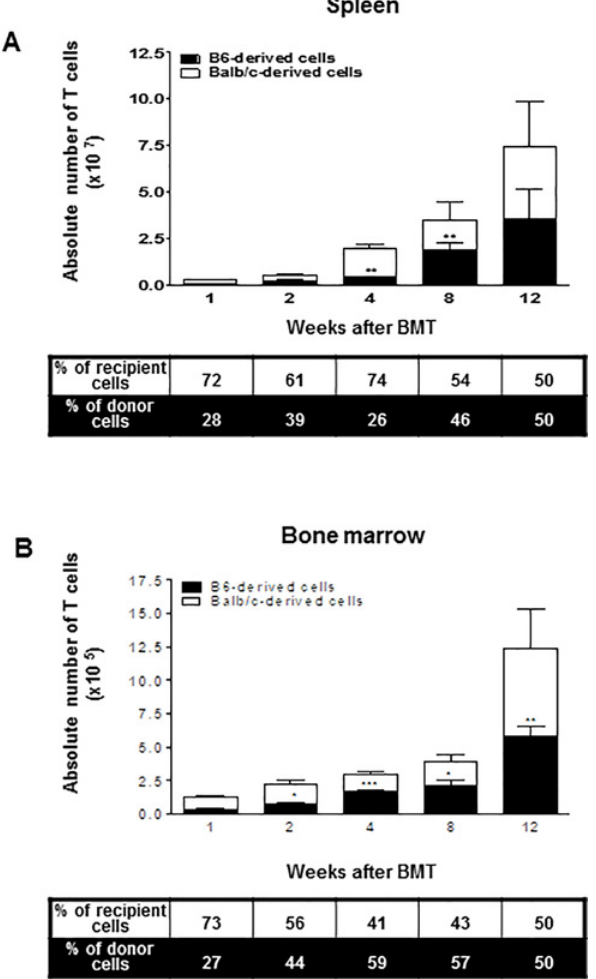
Fig 4. At weeks 1, 2, 4, 8, and 12 after BMT, leukocytes isolated from the spleen and bone marrow were stained with anti-TCR β ,-K b , and-D d monoclonal antibodies ( n = 4 at each time point). The bars show the ratio and absolute numbers of B6-orginated TCR β + T cells ( ■ ) and Balb/c-originated TCR β + T cells ( □ ). Data are shown as the mean ± SD. p values compared to donor-derived cells one week after BMT. ***